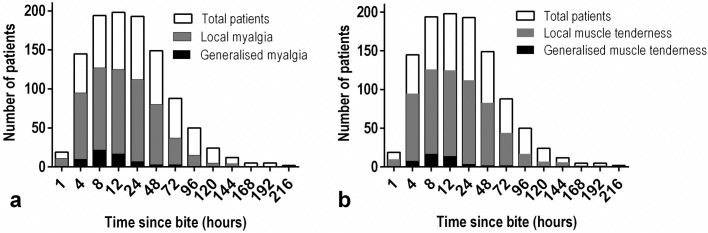
Clinical features of myotoxicity in 245 confirmed Sri Lankan Russell’s viper envenomings (a), the presence of localised and generalised myalgia over time; (b), the presence of localised and generalised muscle tenderness over time. Note: data of all 245 patients were not available at any given time because some patients were admitted later than the time point or discharged before the time point, or the clinical assessment of the patient was not possible at that time point because the patient was sedated, unconscious or transported away for investigations.